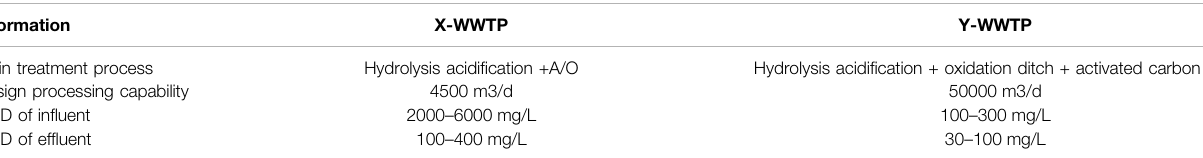
TABLE 1 | Additional information of Two